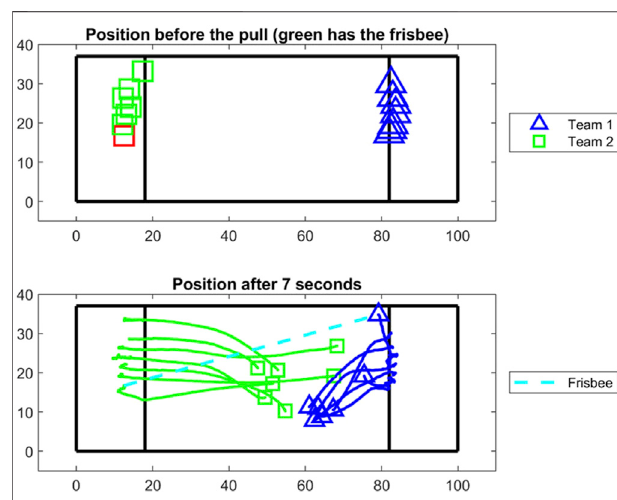
FIGURE 8 | Tracking data recorded with a drone from an Ultimate Frisbee game during the pull and 7 s afterwards. Team 2 (red square) has the frisbee (upper fi eld). Frisbee was not tracked; blue dashed line represents the vector from starting to end position of the